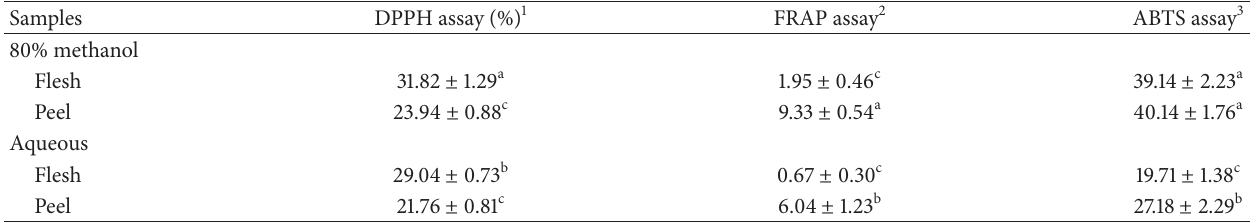
Table 2: Antioxidant properties of extracts of different parts of C. betacea , assessed by three different assays. Samples